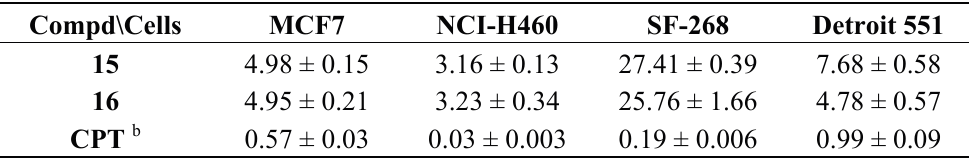
Table 3. Inhibition of in vitro cancer cell lines by benzo[ f ]indole-4,9-dione derivatives [IC 50 ( μ M) ± standard deviation] a